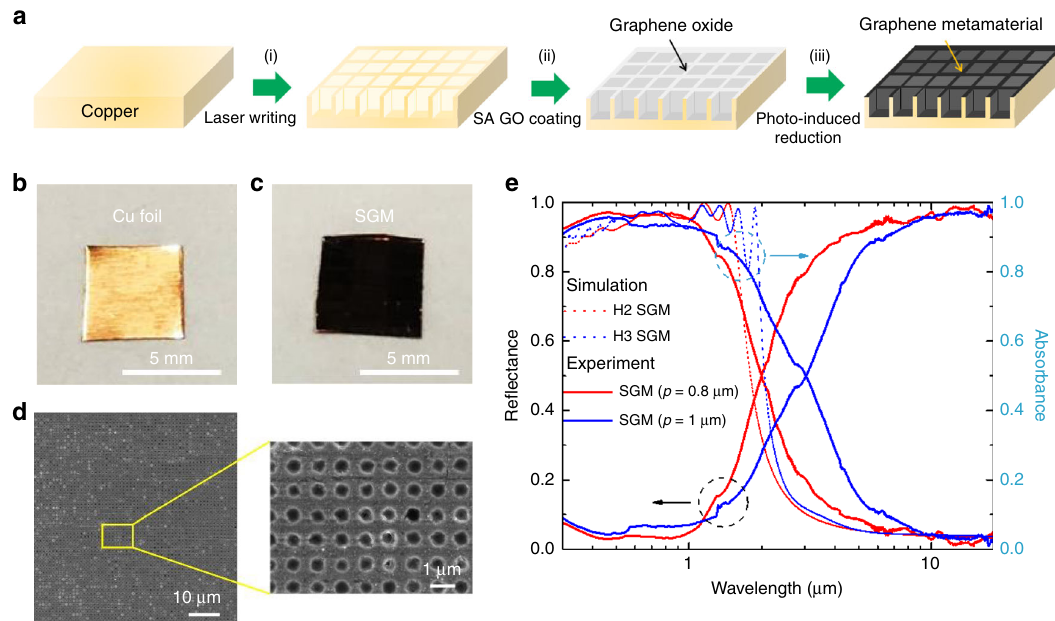
Fig. 4 Fabrication and characterization of SGM absorbers. a Schematic representations of steps in fabrication processes for preparing 3D SGM absorbers. b , c Photographs of b Cu foil and c SGM absorber, each having sample area of ~25 mm 2 . d Top-view SEM images of the SGM absorber at low and high magni fi cation. e Measured re fl ectance and absorbance spectra of SGM absorbers having various hole widths ( w ) and periods ( p ): that is, w / p = 0.52/0.8 μ m (red line) and w / p = 0.57/1 μ m (blue line). The red dashed line and the blue dashed line are the simulated absorbance spectra of the H2 and H3 SGM absorbers, Fig. 8. As a result, the SGM strategy features omnidirectional absorption and high solar-thermal energy conversion capabilities under unpolarized light, suggesting that the proposed SGM absorber has promising potentials for use in practical applications of solar-thermal energy conversion.